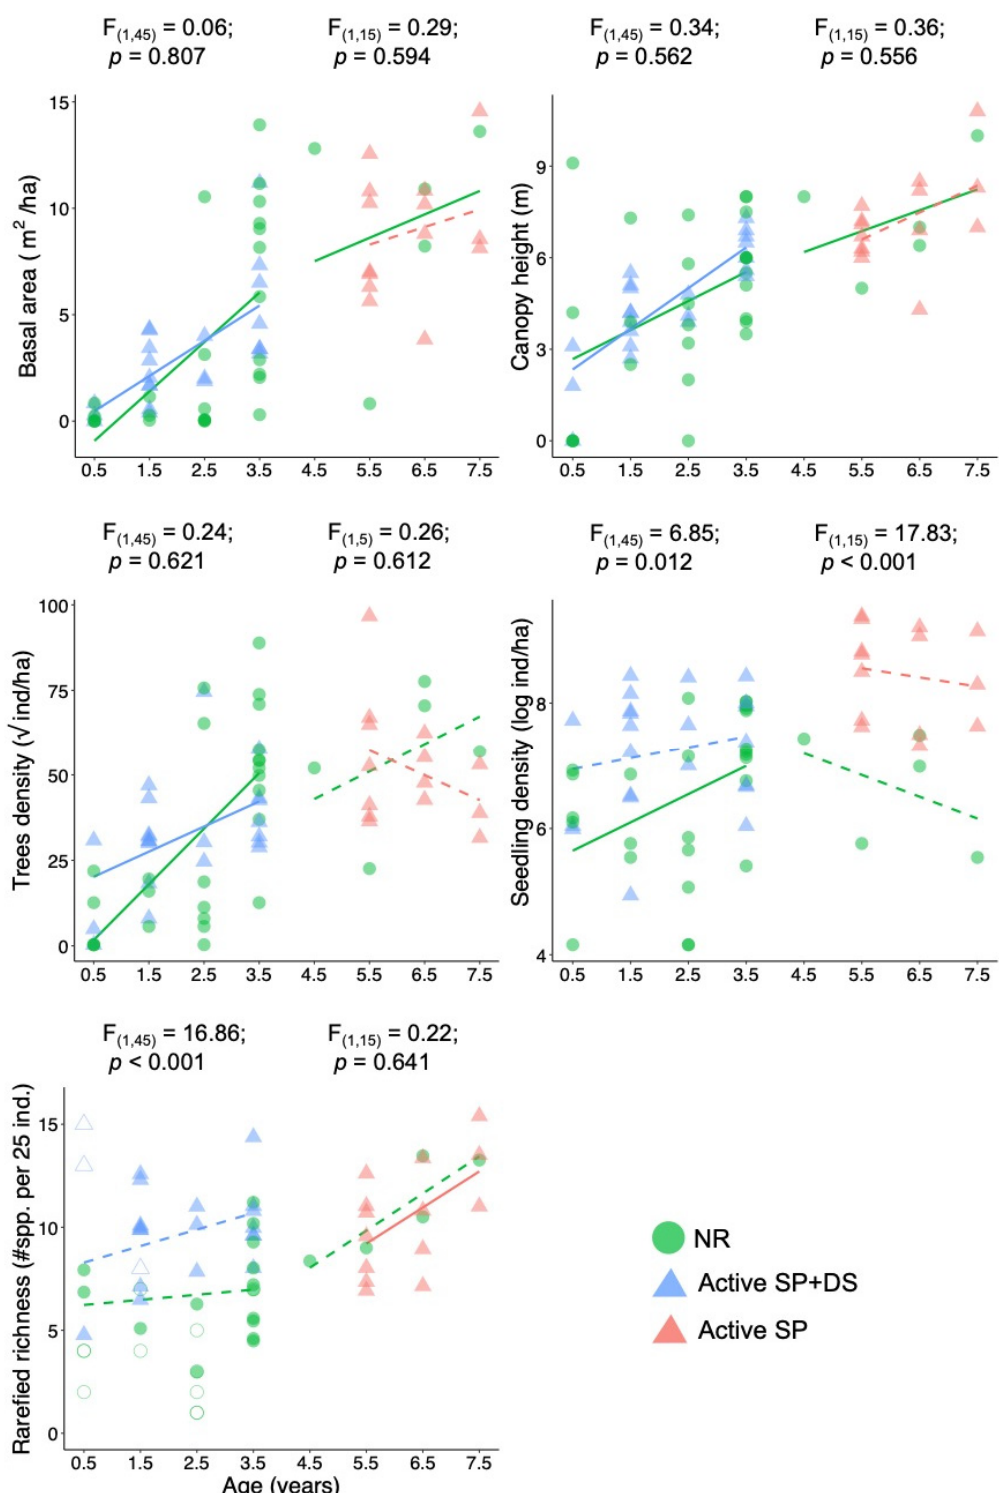
Figure 2. Forest structure attributes of vegetation community in active restoration and natural regeneration sites, located south of Jirau Hydroelectric Reservoir, along the upper Madeira River. Dots and triangles represent sampled sites. Regression lines describe the trajectories of the attribute over time divided in two blocks: 0.5–3.5 y-old sites, where active restoration included seedling planting and direct seeding of pioneer species (AR SP+DS) and 4.5–7.5 y-old sites, where it included only seedling plantings (Active SP). In the rarefied richness plot, non-filled shapes represent sites with less than 25 individuals sampled and absolute richness values were used in the plot, but not considered for the regression